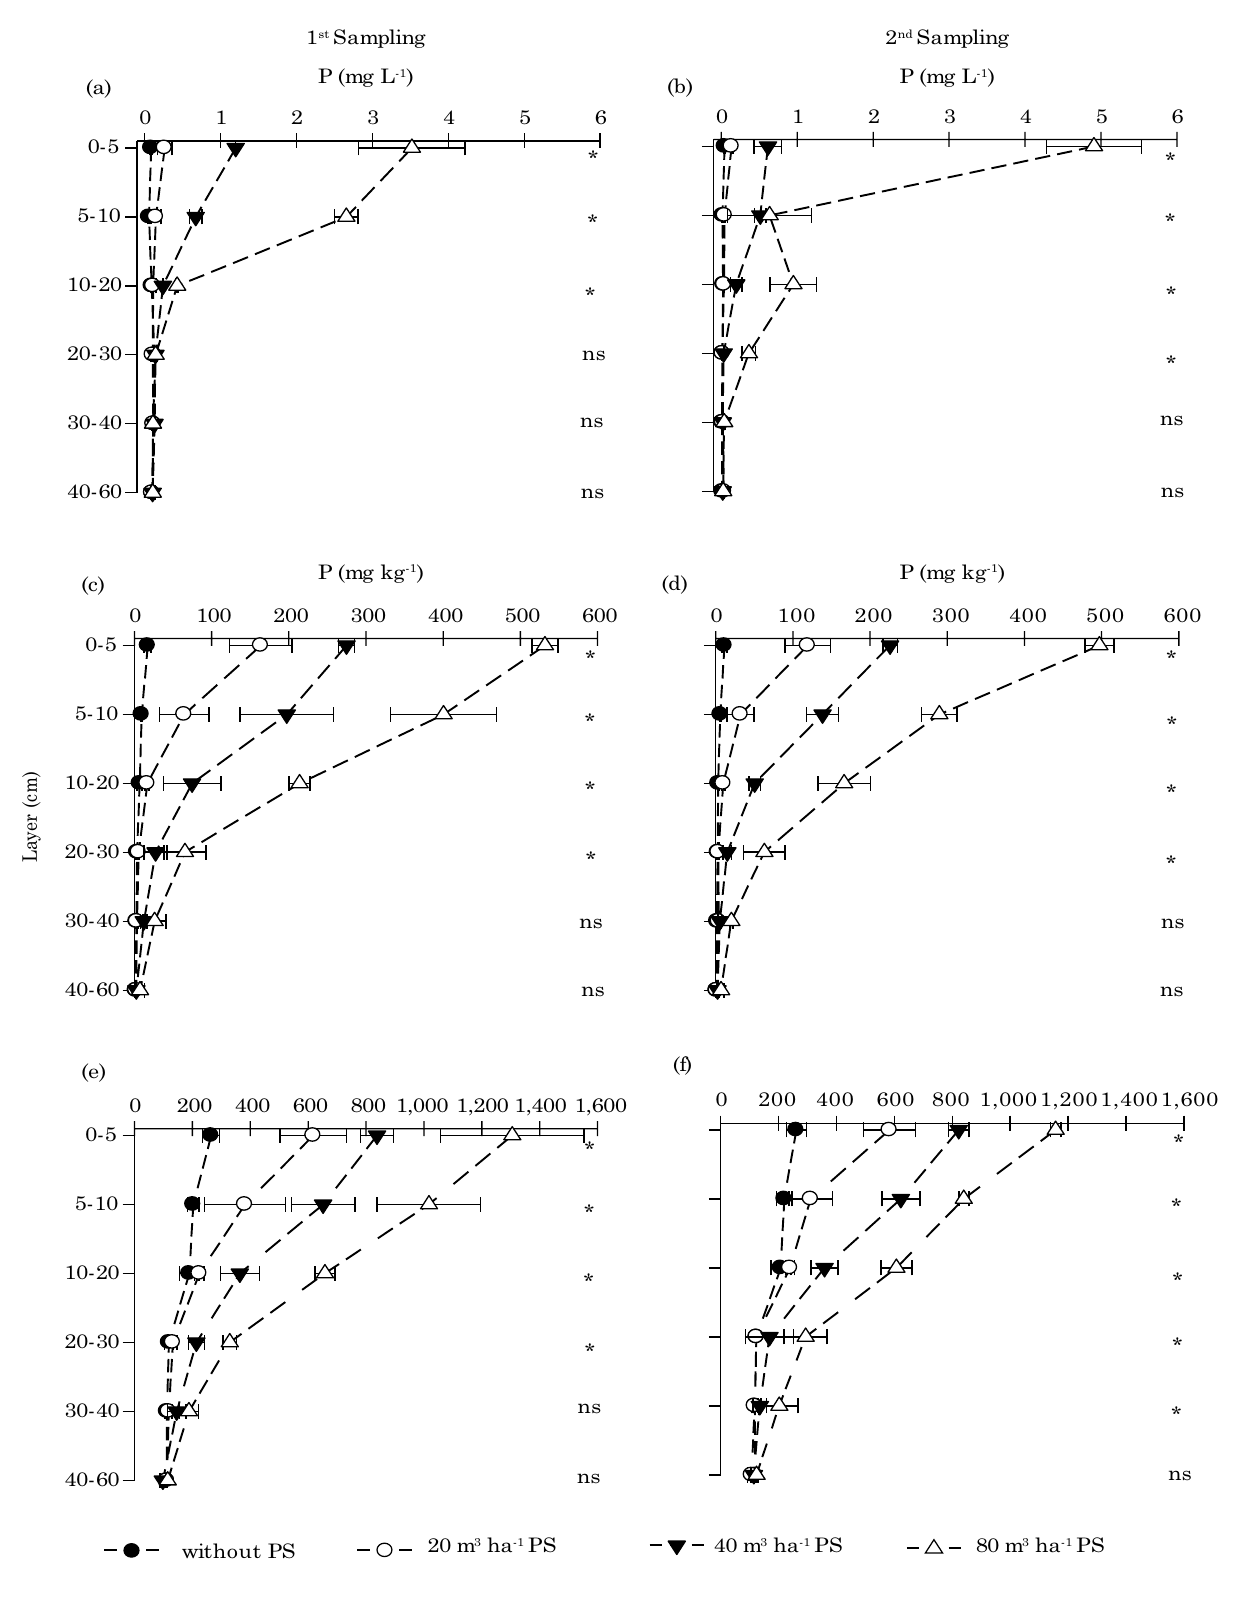
figure 1. Phosphorus in solution (a, b), P extracted by mehlich-1 (c, d), total P (e, f) in the 1 st and 2 nd sampling, in a typic hapludalf soil treated with 0, 20, 40, and 80 m 3 ha -1 pig slurry. *: significant at 5 %; ns :